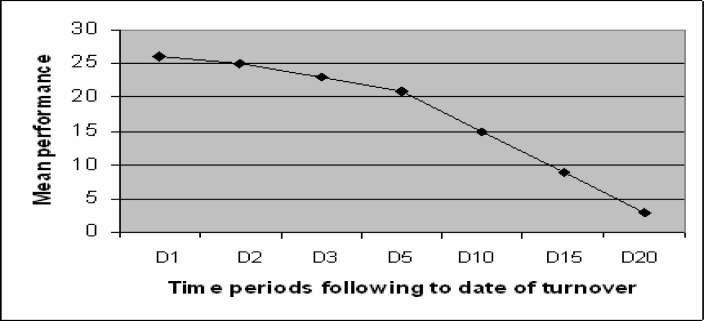
Evolution over time of the winning effect of the new coach